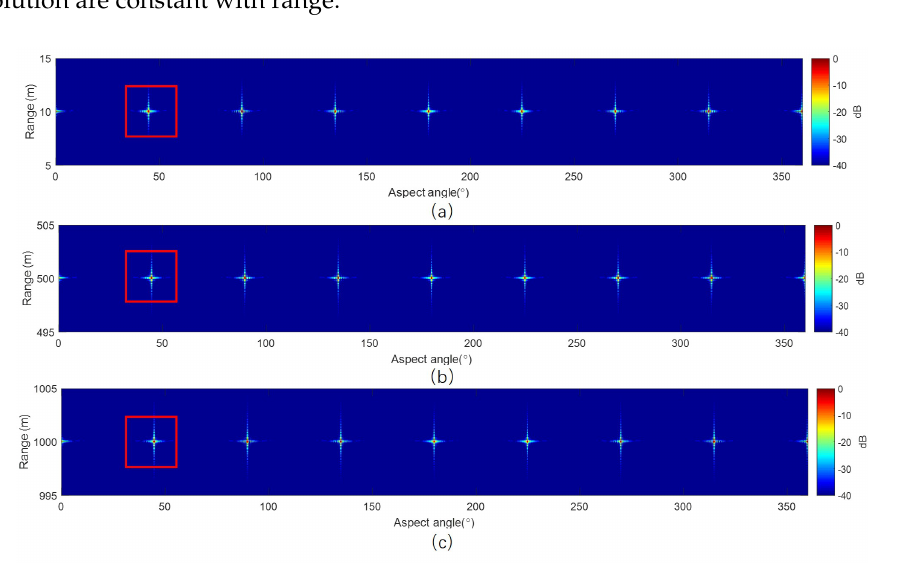
Figure 7. Imaging results with our algorithm: ( a ) Image of targets at near range. ( b ) Image of targets at center range. ( c ) Image of targets at far